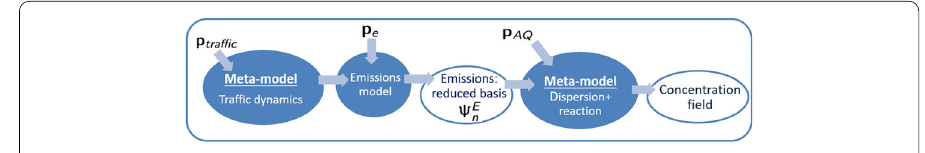
Fig. 1 Meta-modeling chain over